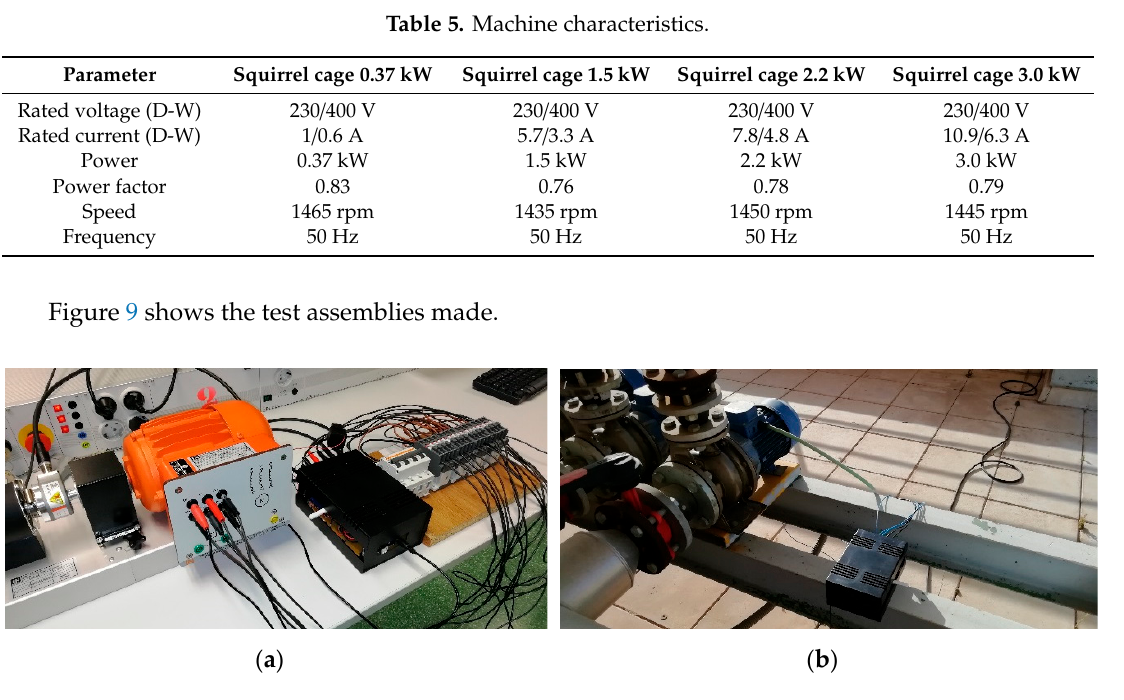
Figure 9. Final assemblies for motor test: ( a ) IM 0.37 kW (IMEMSL #1); ( b ) IM 3.0 kW (IMEMSL #4).